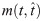
Different interpretations of the function m(t,t^) (red line).(A) As a function of t^ (or as a function of k in discrete time), m(tl, tk) represents the distribution of last spike times t^i across the population at time t = tl. (B) As a function of time t (or as a function of the index l in discrete time), m(tl, tk) represents the survival number, i.e. the number of neurons which fired in the interval [tk, tk + Δt) which survived (did not fire) until time t = tl. The activity Δn(tk), i.e. the number of neurons that fired in the k-th time bin, is depicted by a blue line. The population size is N = 1000.